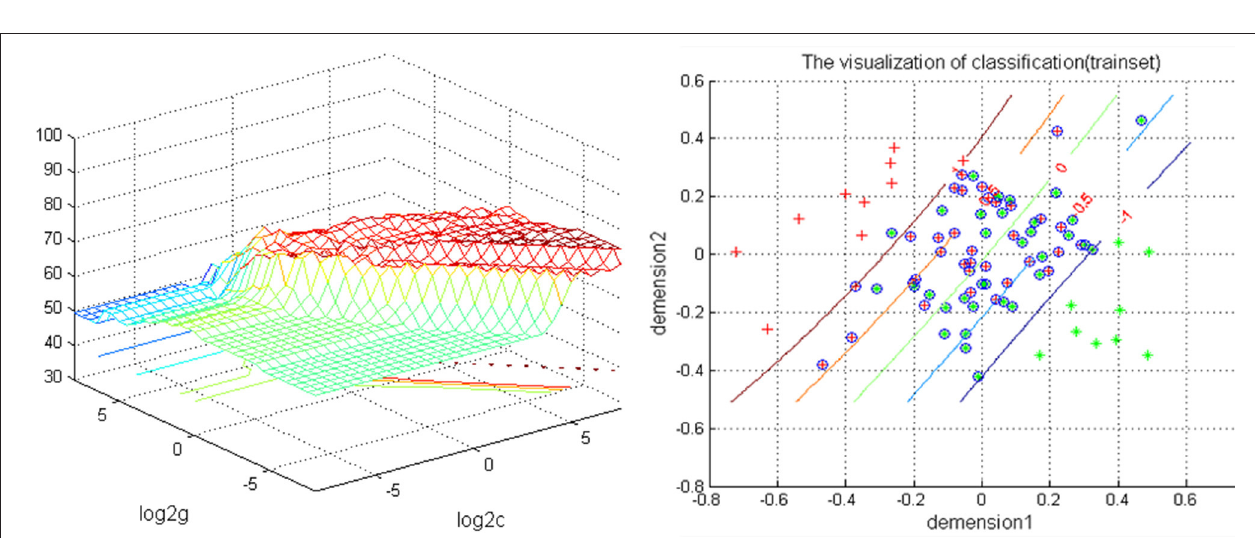
FIGURE 1 | NH differences between patients with rTLE and HCs. Red and blue denote higher and lower NH, respectively, and the color bars represent the T values from the two-sample t -test of the group analysis. NH, network homogeneity; rTLE, right temporal lobe epilepsy; HCs, healthy controls.